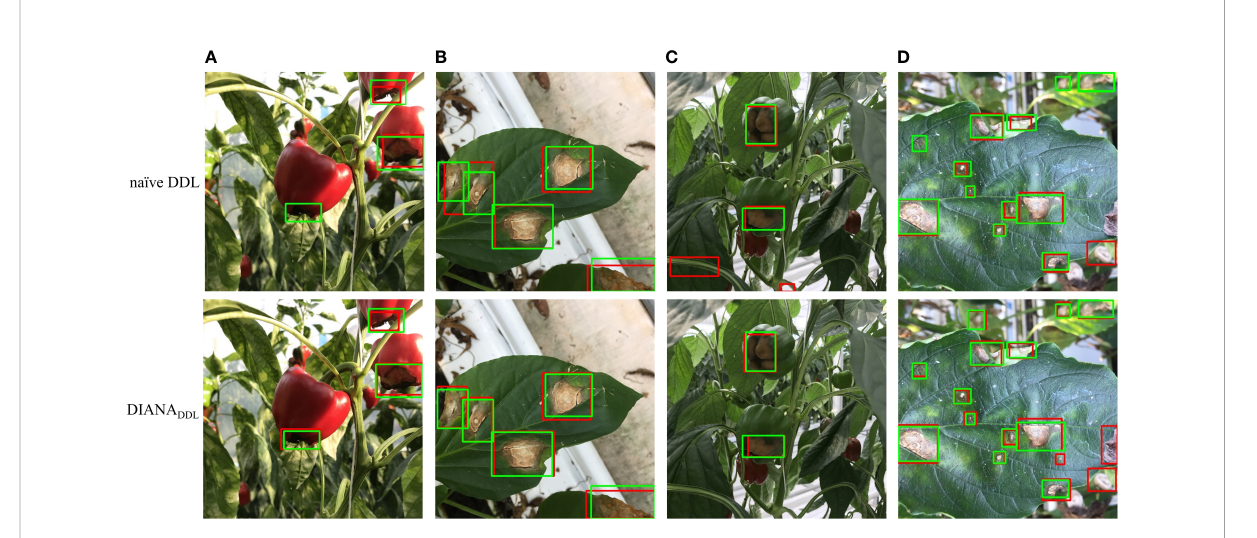
FIGURE 11 Comparison of qualitative results for coupled and decoupled DDL